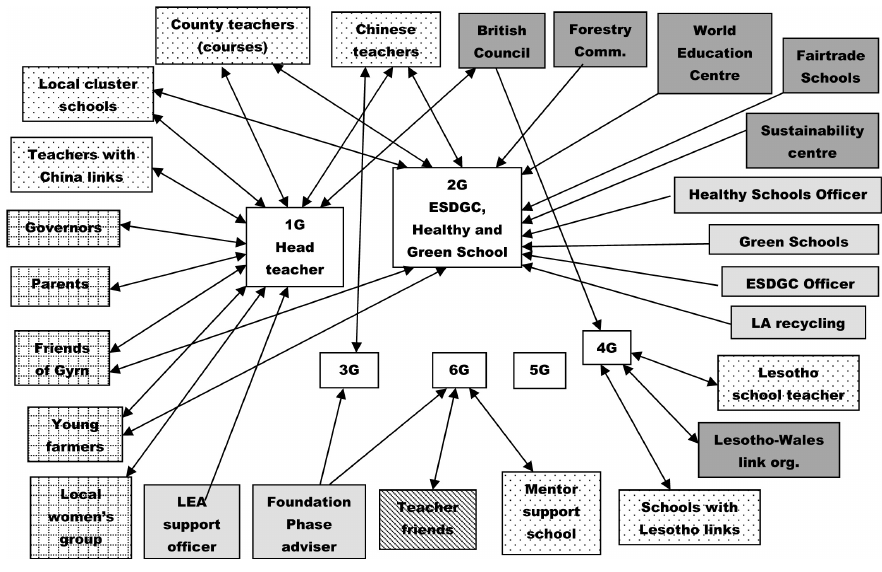
Figure 1a: Gyrn teachers’ external networks